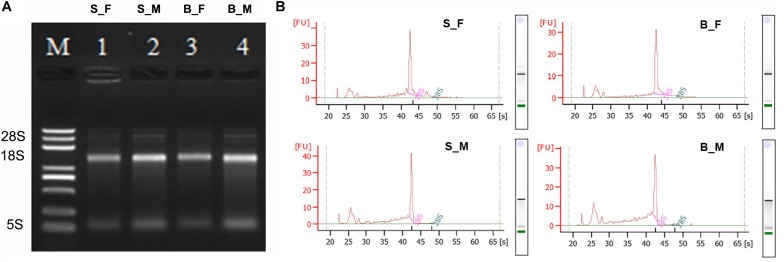
Qualitative and quantitative integrity identification of the total RNA of the Schistosoma japonicum worm samples. (A) Qualitative integrity identification of the total RNA of the S. japonicum worm samples by denatured agarose gel electrophoresis. Of the total RNA from each sample, 3 μl was loaded on 1.2% denaturing agarose gel with ethidium bromide (EB). The voltage of the electrophoresis was 65 V. The gel was observed and photographed with an ultraviolet transmission analyzer after the electrophoresis was finished. The 28S rRNA bands are absent, the 18S rRNA bands are present as the main bands with appropriate peaks, and the second bands are the weaker 5S bands. Therefore, the in vivo nick of the L-rRNA of S. japonicum worms total RNA was observed and confirmed here, which indicated good integrity of the total RNA of the S. japonicum worm samples in this study. M: RNA ladder. 1: S_F; 2: S_M; 3: B_F; 4: B_M. (B) Quantitative integrity identification of the total RNA of the S. japonicum worm samples by an Agilent 2100 Bioanalyzer. The peaks of 28S rRNA are also absent and the peaks of 18S rRNA are present as the main peaks for all four samples. Therefore, the in vivo nick of the L-rRNA in S. japonicum worms total RNA was also observed and confirmed here, which further indicated the good integrity and purity of the total RNA of the S. japonicum worm samples used here. B_F female worms from BALB/c mice, B_M male worms from BALB/c mice, S_F female worms from SCID mice, S_M male worms from SCID mice.